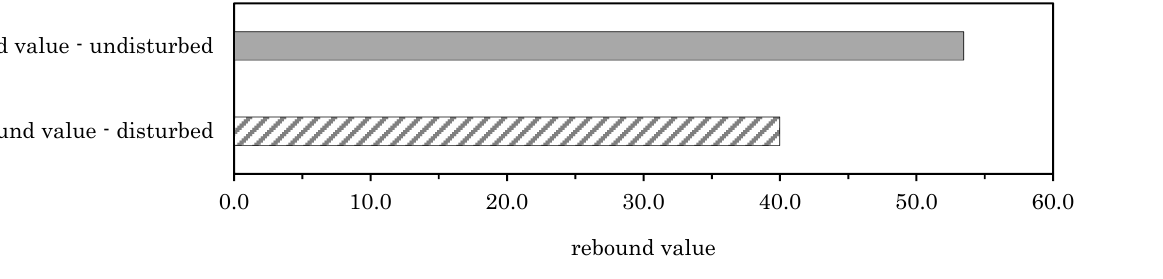
Figure 7. Mean rebound values for disturbed and undisturbed areas for all rock types.